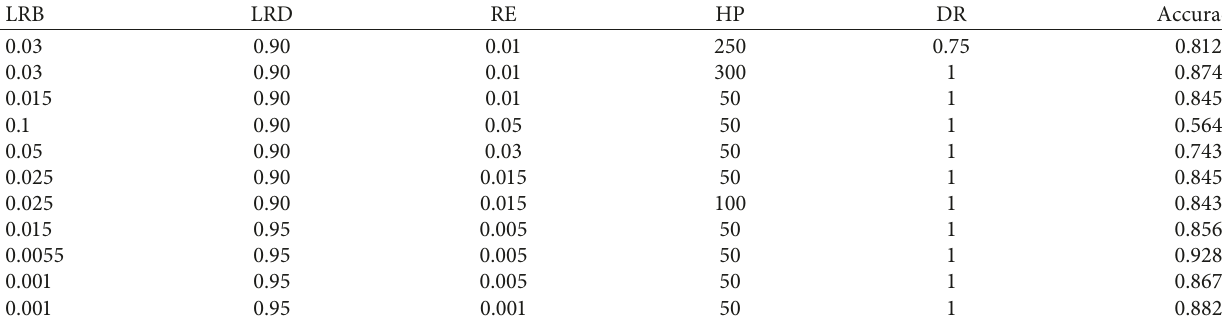
Table 3: Parts of the experiment results.